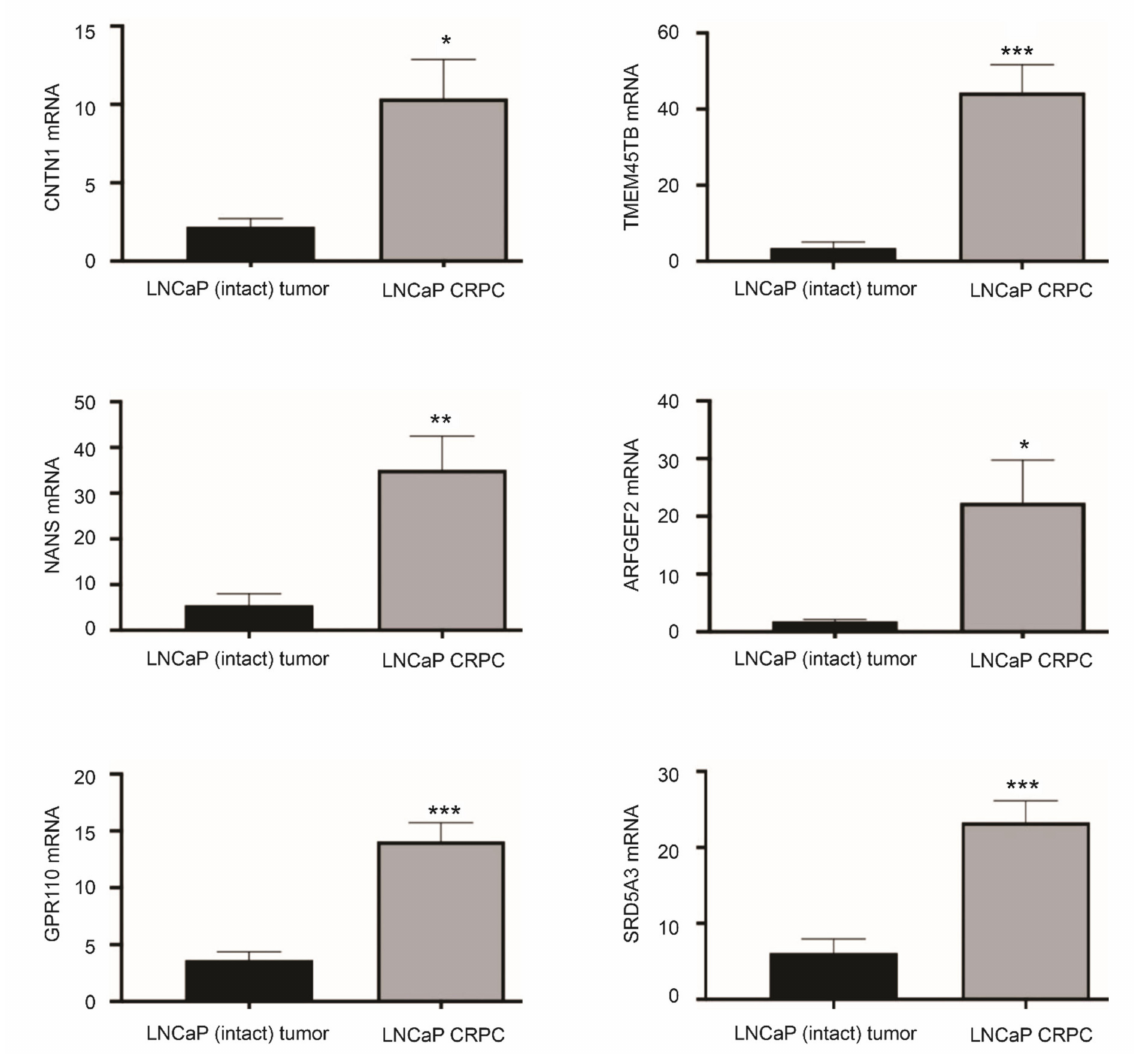
Figure 6. Differential expression of LE genes in LNCaP CRPCs compared to androgen-sensitive LNCaP tumors. LNCaP cells were used to produce xenografts in intact NOD/SCID or castrated animals (CRPC). The expression of the indicated genes was determined by real-time PCR in LNCaP intact tumors ( n = 6) and LNCaP CRPCs ( n = 5). * p < 0.05; ** p < 0.01, *** p < 0.001 in comparison to LNCaP EV tumors. Statistical analyses were performed using Student t-test